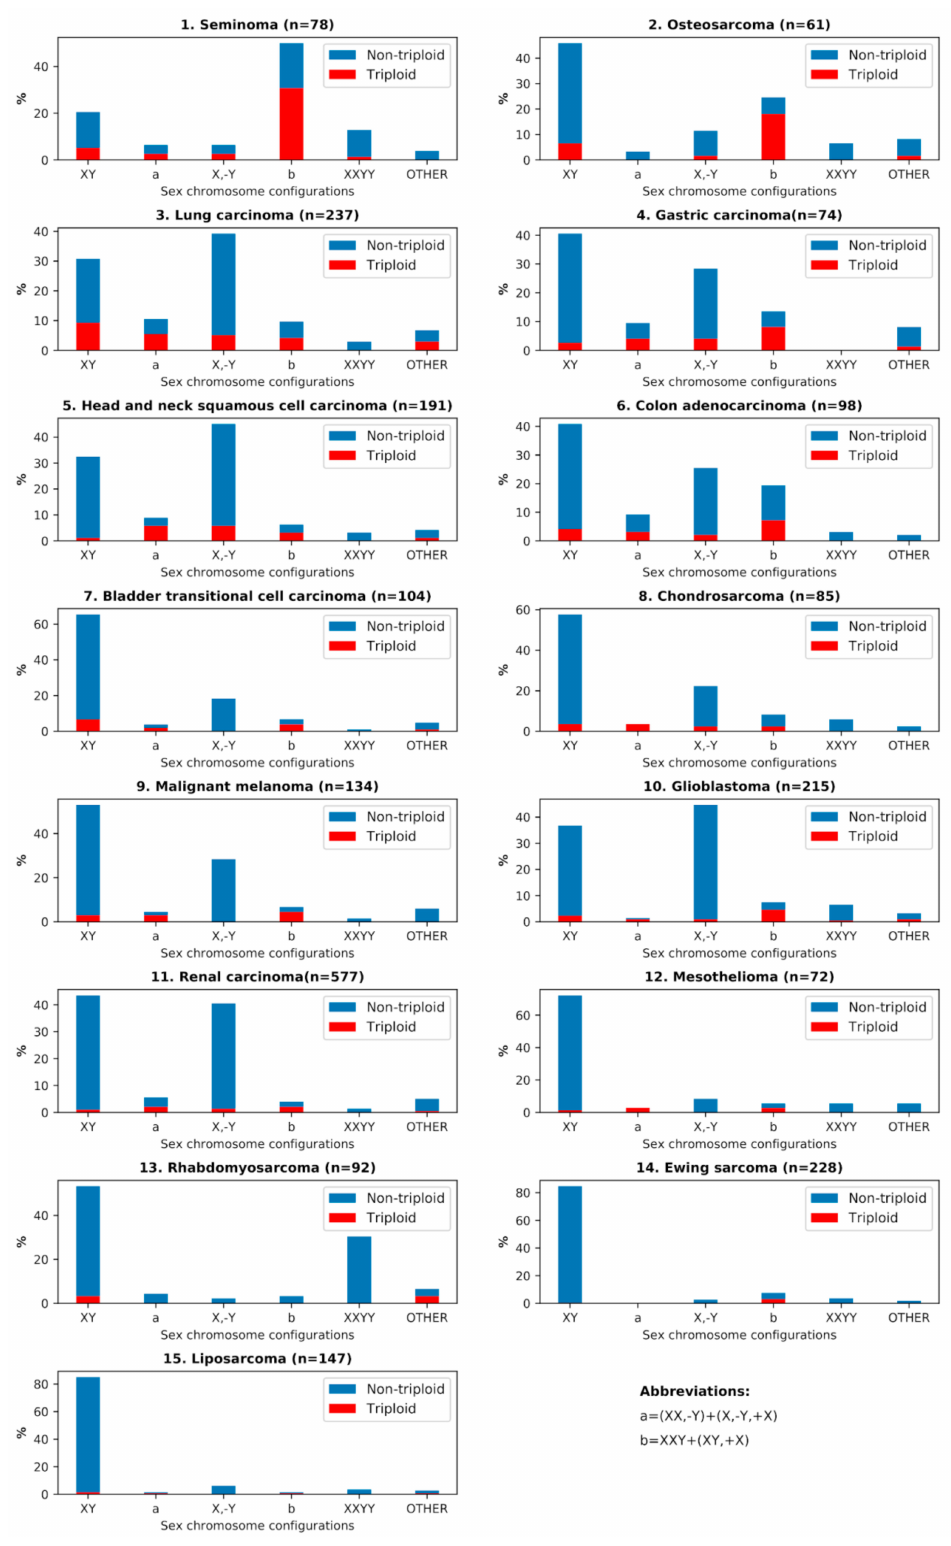
Figure 4. The percentages of di ff erent sex chromosome configurations and their respective percentages of near-triploidy (62–76 chromosomes) for all malignant tumor cohorts, numbered as listed in Table